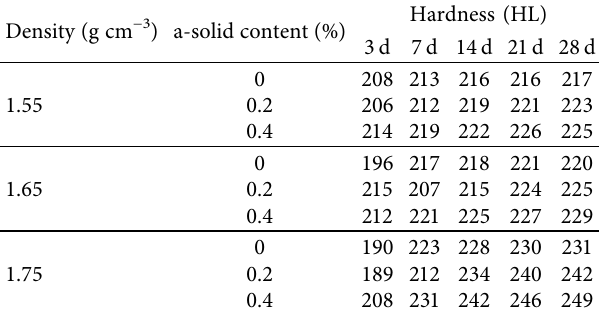
Figure 4(a): the compressive strength of 1.55 g/cm 3 sample varying with age; Figure 4(b): the compressive strength of 1.65 g/cm 3 sample varying with age; Figure 4(c): the compressive strength of the 1.75 g/cm 3 sample varying with age.